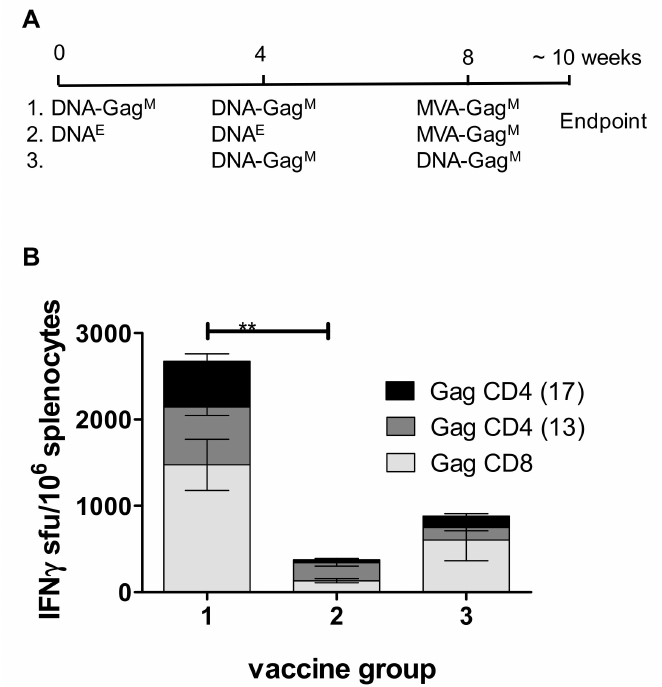
Figure 3. DNA vaccine elicits high Gag-specific IFN- γ ELISPOT responses both alone and in a heterologous prime boost with MVA. ( A ) Vaccination schedule. DNA-Gag M = pTHPcapR containing mosaic gag ; DNA E = pTHPcapR empty vector; MVA-Gag M = MVA containing mosaic gag . ( B ) Cumulative IFN- γ ELISPOT CD8 + and CD4 + responses of vaccinated mice to HIV-1 Gag peptides. ** p < 0.01 Student t -test of unpaired